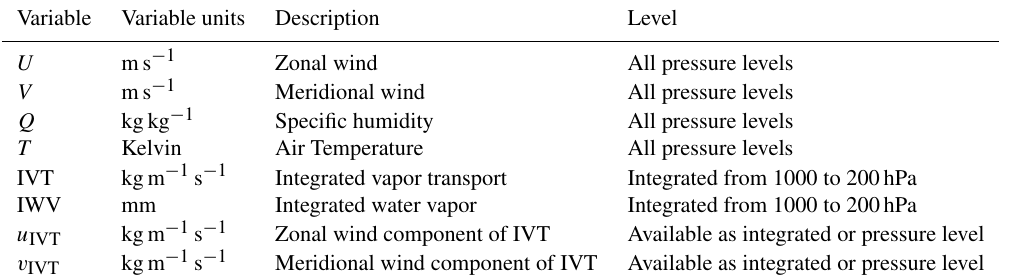
Table 3. ARTMIP variables available for detection